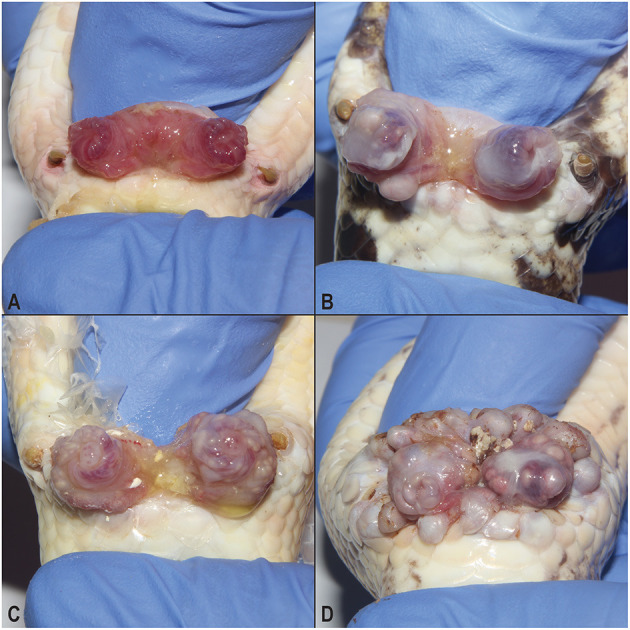
Hemipenal lesions in breeding male ball pythons (Python regius). Normal everted ball python hemipenes (A) compared to a syndrome of hemipenal inflammation (B–D). Inflammation and irritation ranged from mild (B), to moderate (C), to severe (D) which was associated with mass formation along the margins of the vent.